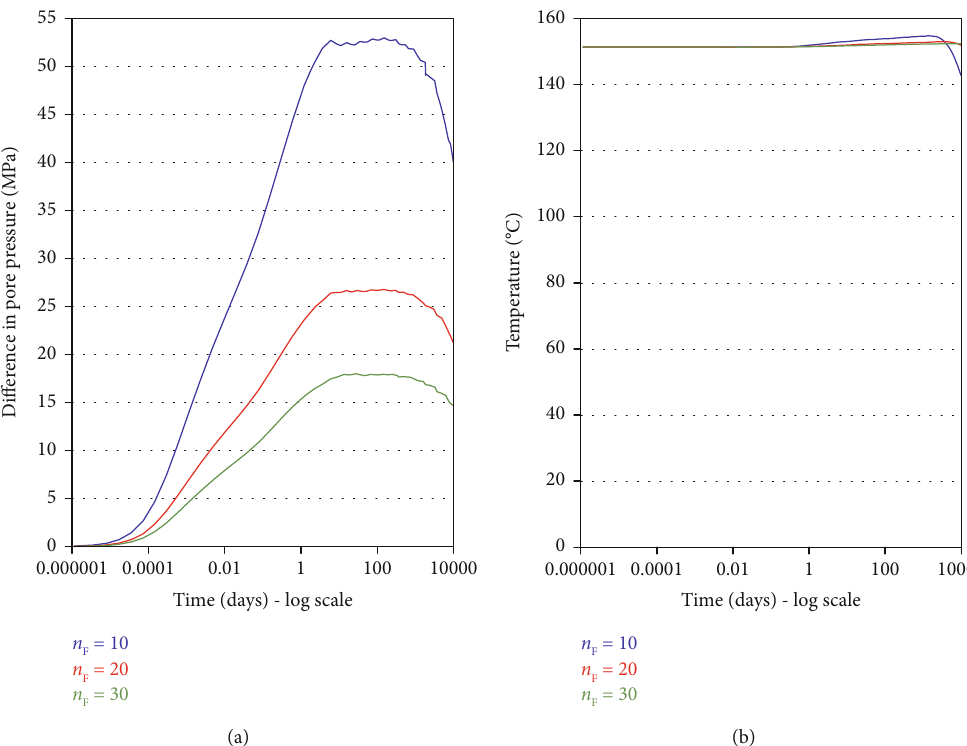
Figure 10: Variation with time of the di ff erence in the fl uid pore pressure between the injection and production boreholes (a) and temperature at the production borehole (b) ( n F is the number of fracture